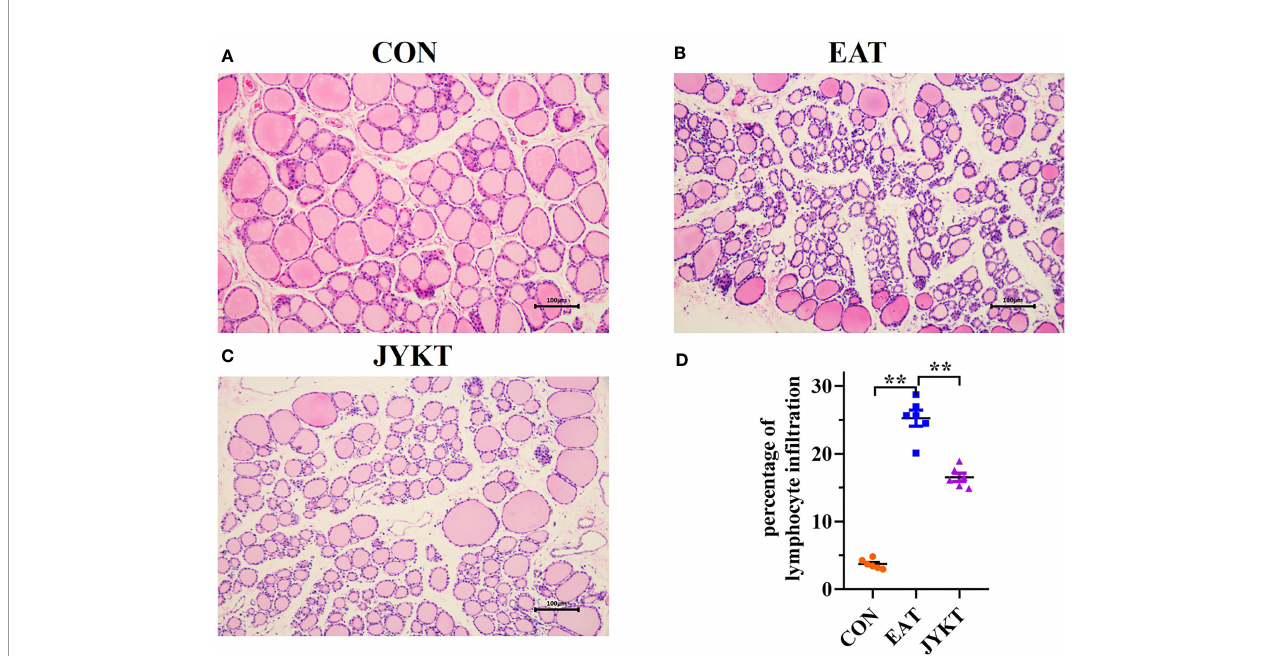
FIGURE 5 | Pathology of thyroid in the CON (A) , EAT (B) and JYKT group (C) by H&E staining (200×). (D) Percentages of lymphocytic in fi ltration area among groups. ** P < 0. 01.